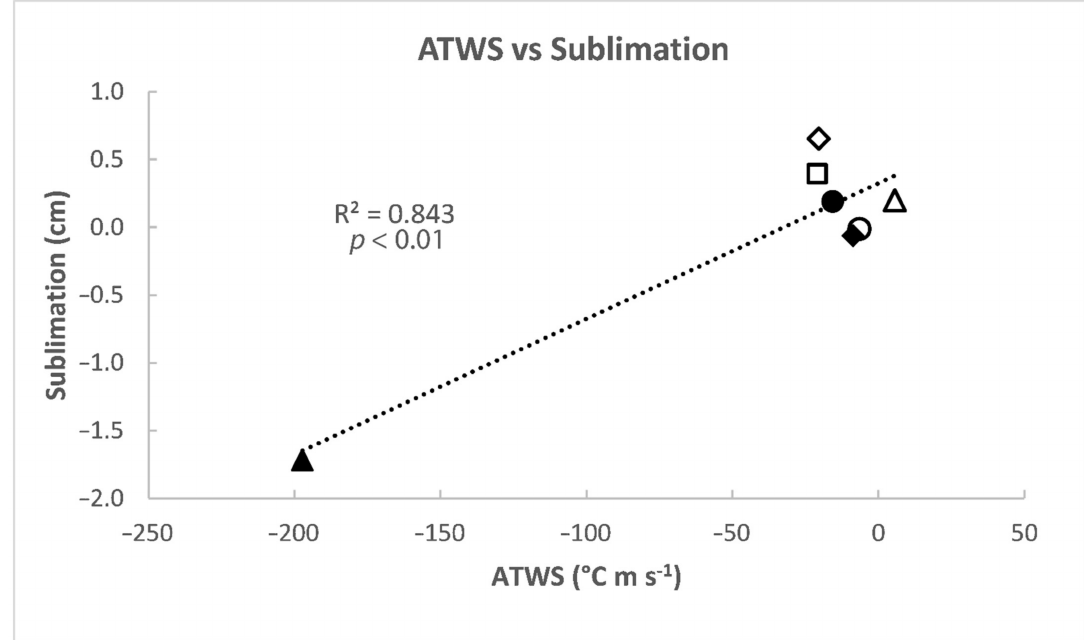
Figure 7. Linear regression between the ATWS and the average measured height of all the tubes during the period between 22/11/18 and 16/01/2019 (negative values correspond to loss of ice and positive values correspond to accretion of ice). R 2 = 0.84 and p < 0.01. The different symbols indicate the date of measurement: black triangle 22/11/18, white square 1/12/18, black rhombus 11/12/18, white triangle 19/12/18, white rhombus 27/12/18, black circle 07/01/19, white circle